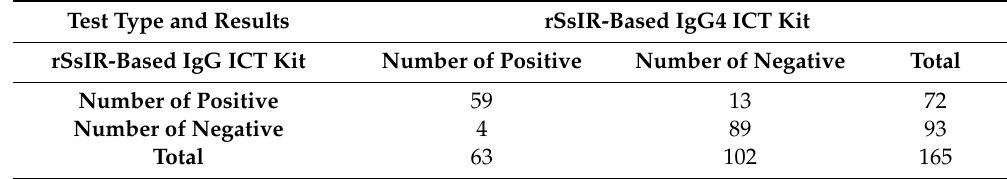
Table 2. Comparison between the rSsIR-based IgG ICT kit and rSsIR-based IgG4 ICT